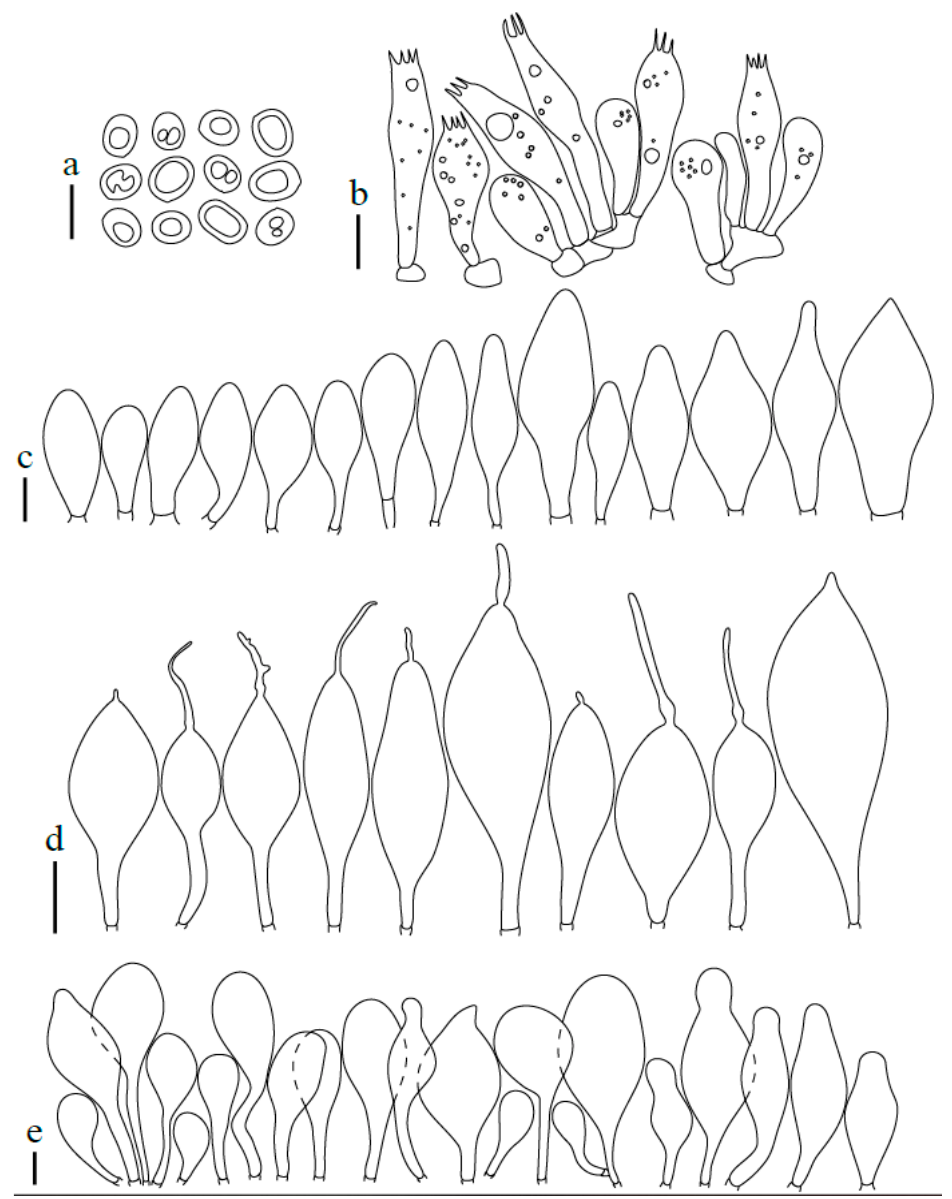
Figure 14. Pluteus reisneri OKA-TR1823: ( a ) spores; ( b ) basidia and basidioles; ( c ) pleurocystidia; ( d ) cheilocystidia; ( e ) pileipellis elements. Scale bars: 10 µm.